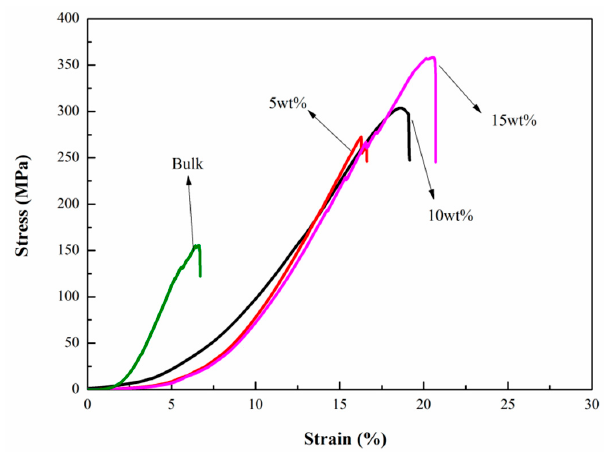
Figure 3. Compressive stress-strain curves for LaFe 11.6 Si 1.4 H y /Bi composites with 5, 10 and 15 wt % metallic Bi, respectively, in comparison with that of bulk LaFe 11.6 Si 1.4